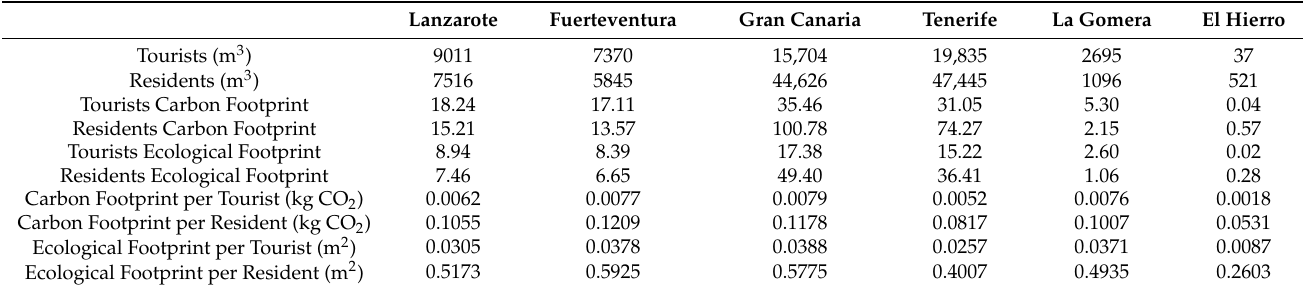
Table 20. Water consumption, Carbon, and Ecological Footprints by islands for tourists and Canary residents in one year (m 3 )